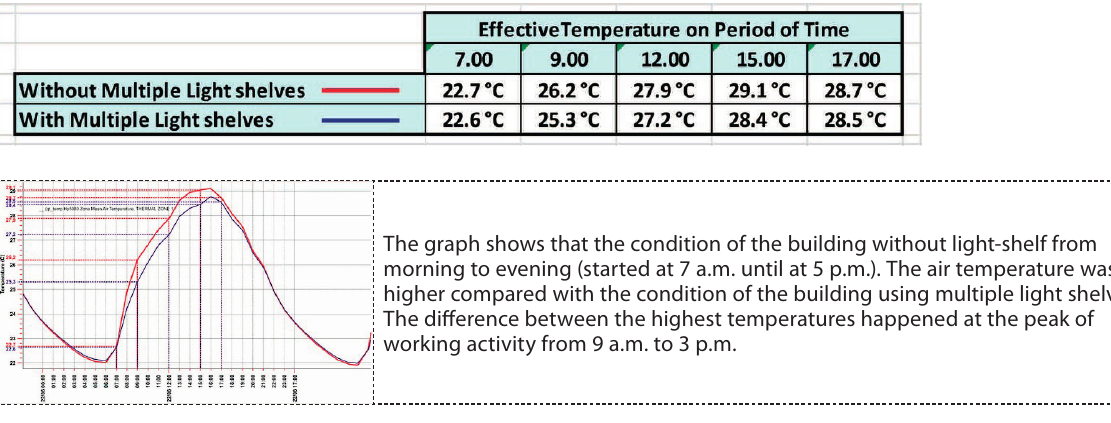
Table 1. The Comparison of the effective air temperature average